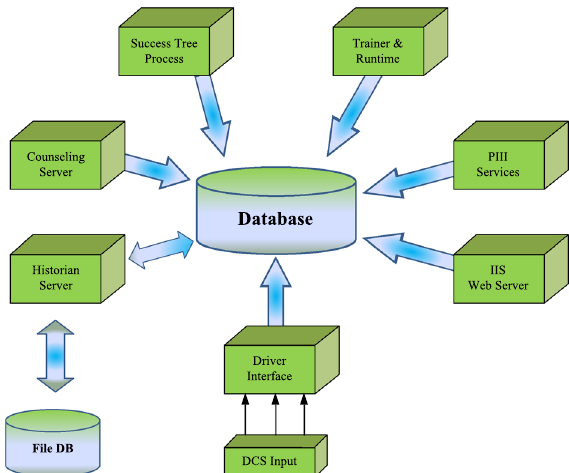
Figure 11. Server architecture of the PHI system 26 .